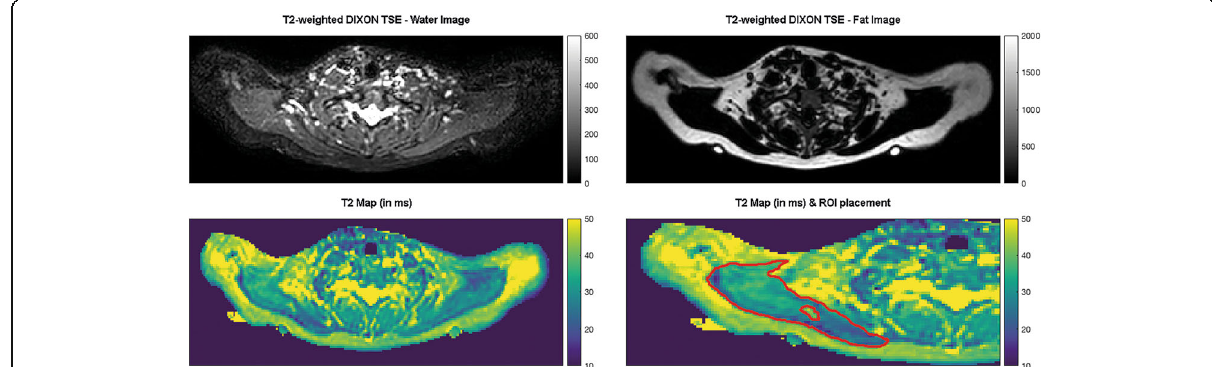
Fig. 1 Magnetic resonance imaging (MRI) including T2 mapping of the upper trapezius muscles. This figure captures an exemplary case by showing representative axial slices of the T2-weighted DIXON turbo spin echo (TSE) sequence (upper row). The left upper corner shows the T2- weighted DIXON TSE water image, the right upper corner captures the T2-weighted DIXON TSE fat image. Furthermore, T2 maps as derived from the T2-prepared TSE sequence are displayed (lower row). The left lower corner pictures the color-coded T2 map, the right lower corner shows the same color-coded T2 map after manual placement of regions of interest (ROIs) in the right upper trapezius muscle and with respect to a signal alteration (T2 elevation) within the muscle. In this exemplary case, the signal alteration was located in the area of a manually defined myofascial trigger point (mTrP), as indicated by the spatial relation to superficially attached nitroglycerine capsules as markers. The signal alteration in terms of the circumscribed T2 elevation shows a T2-hyperintense correlate in the T2-weighted DIXON TSE water